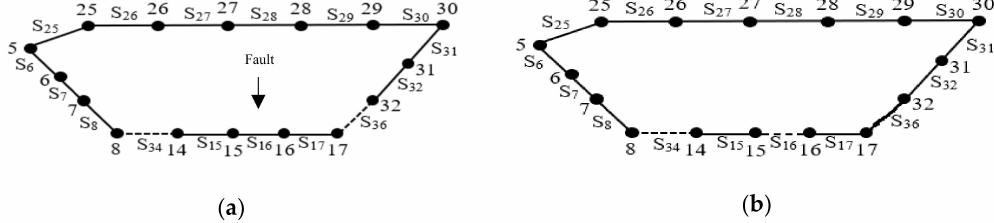
Figure 6. ( a ) Test case 1 single fault at S 16 before service restoration; ( b ) test case 1 single fault at S 16 after service